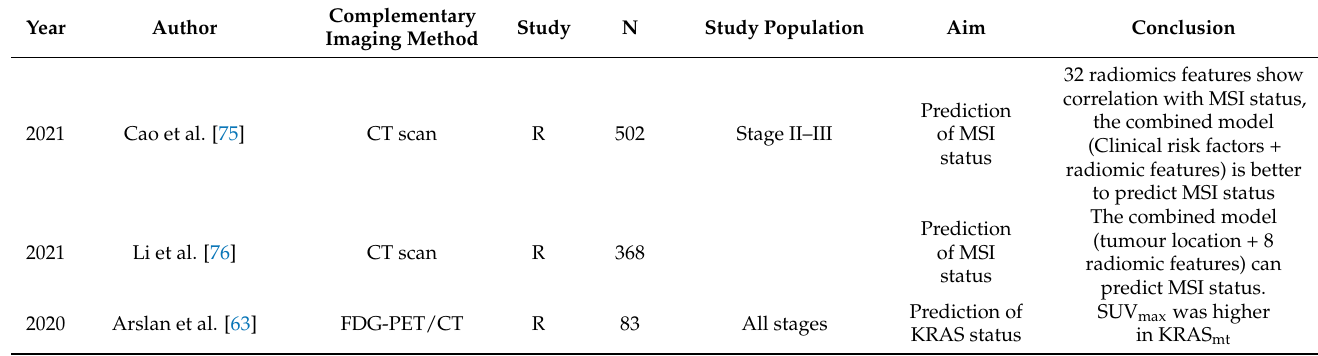
Table 3. Selected colorectal cancer radiogenomics studies on TC/MRI and FDG-PET/TC imaging. CT, computed tomography; MRI, magnetic resonance imaging; FDG-PET, fluorodeoxyglucose positron emission tomography; MSI, Microsatellite instability; SUVmax, Maximum standardized uptake value; KRAS mt , KRAS mutated; BRAF mt , BRAF